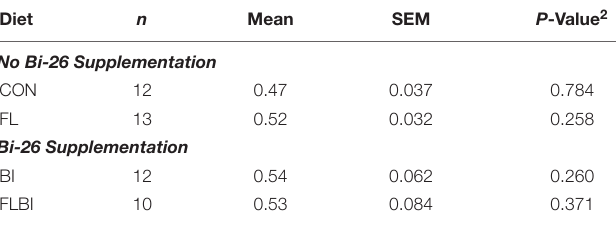
Number of Mean Latency to Latency novel novel novel first novel to object object object object visit visits, n visit time, visit, s time, s s/visit